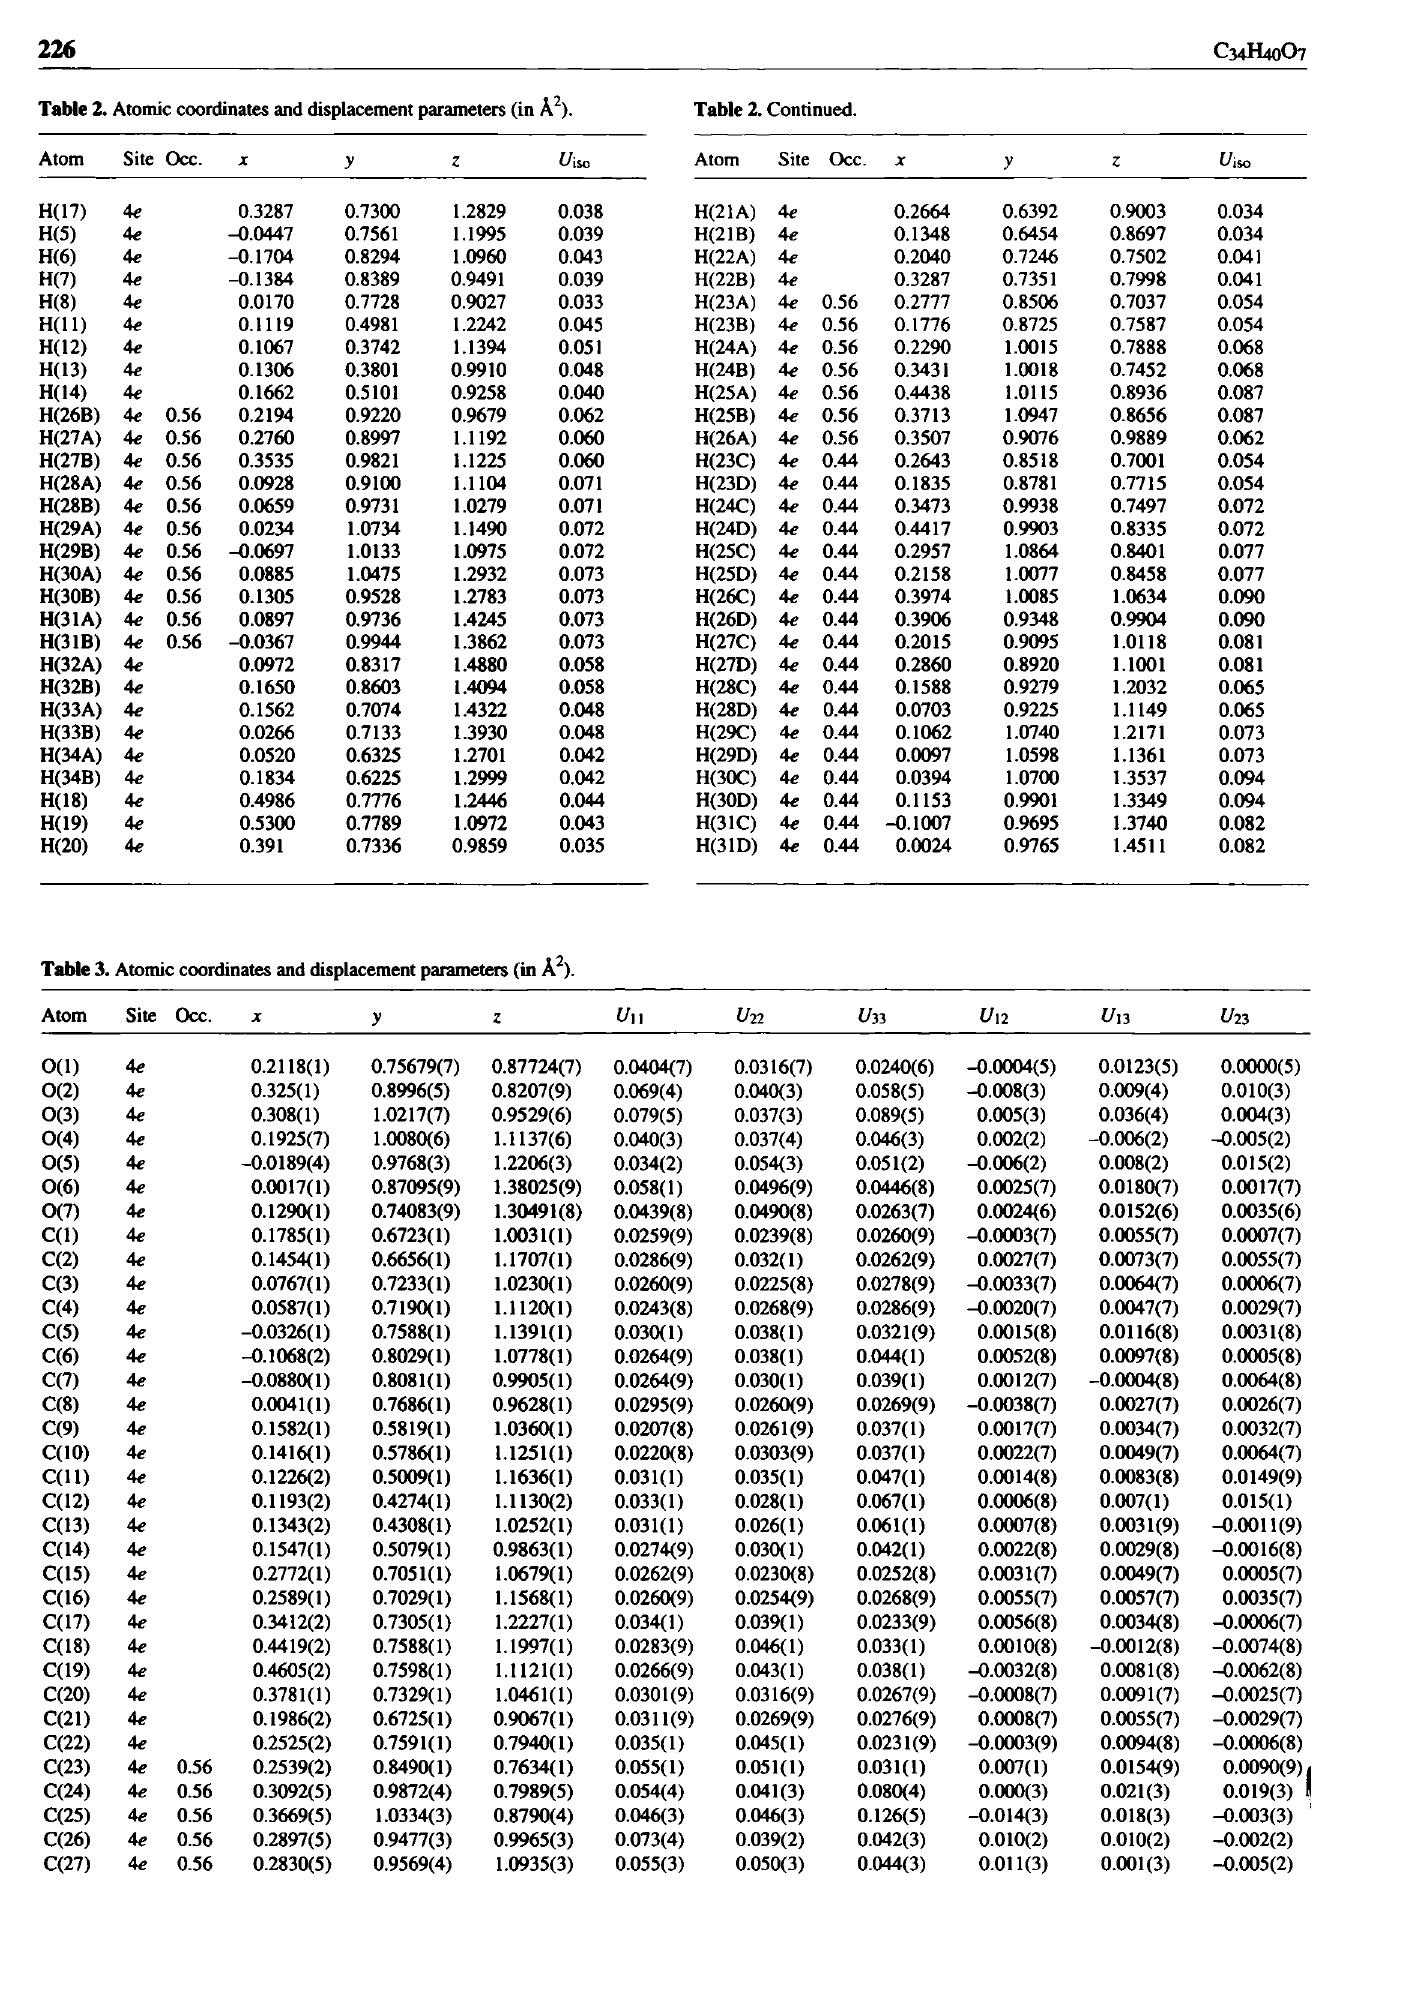
Table 3. Atomic coordinates and displacement parameters (in À 2